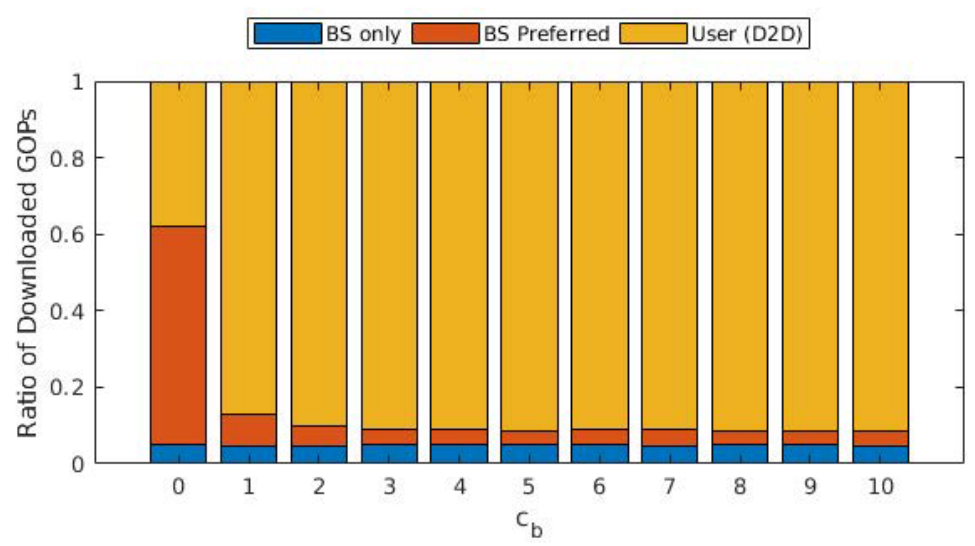
Figure 4. Ratio of the GOPs downloaded from the cloud/base station (blue: GOPs that do not exist in the cache of any of the users and downloaded from the cloud; red: GOPs downloaded from the base station cache), and GOPs downloaded from other users for different values of c b